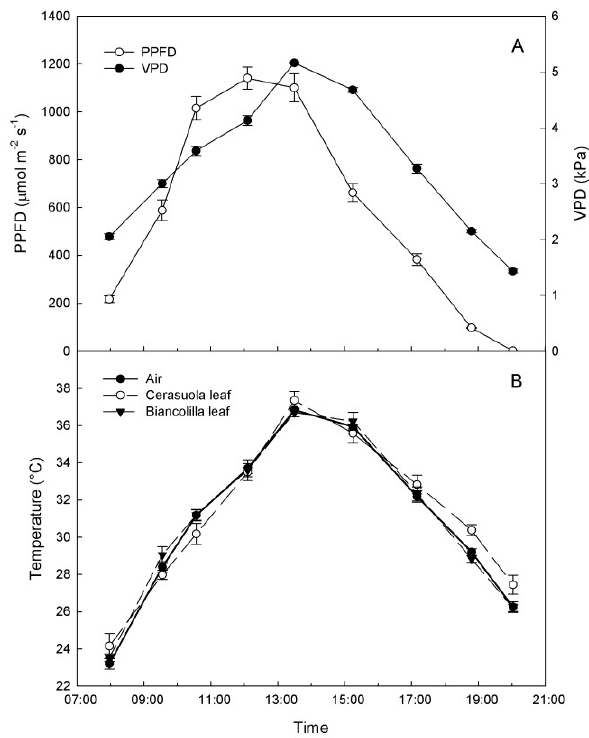
Table 1. Average diurnal relative water content (RWC), stomatal conductance (g transpiration rate (T), mannitol content, and malic acid content in leaves of ‘Biancolilla’ and ‘Cerasuola’ olive trees on 18 August 2007 near Scillato,